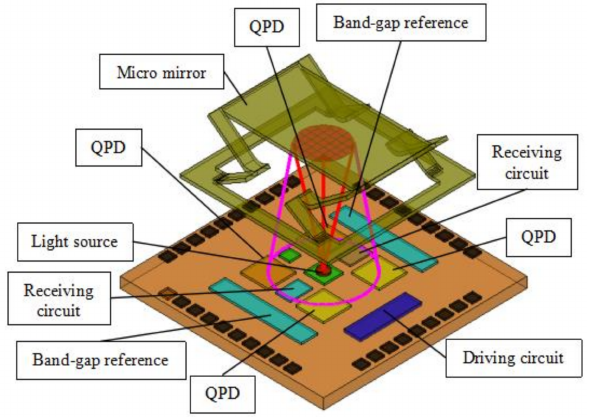
Figure 2. Schematic of the micromirror and integrated optoelectronic position sensor (iOE-PS) module.